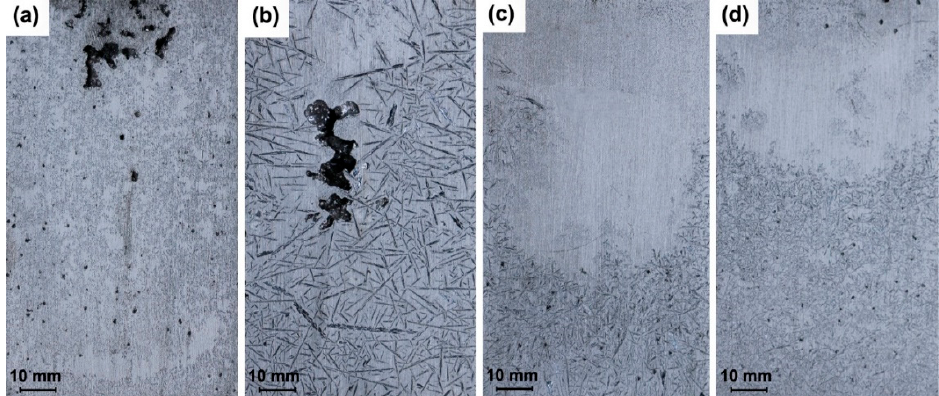
Figure 4. Vertical-sections of Al-30Si alloys with different cooling conditions: ( a ) C I -1, ( b ) C I -2, ( c ) C I -3, ( d ) C I -4.